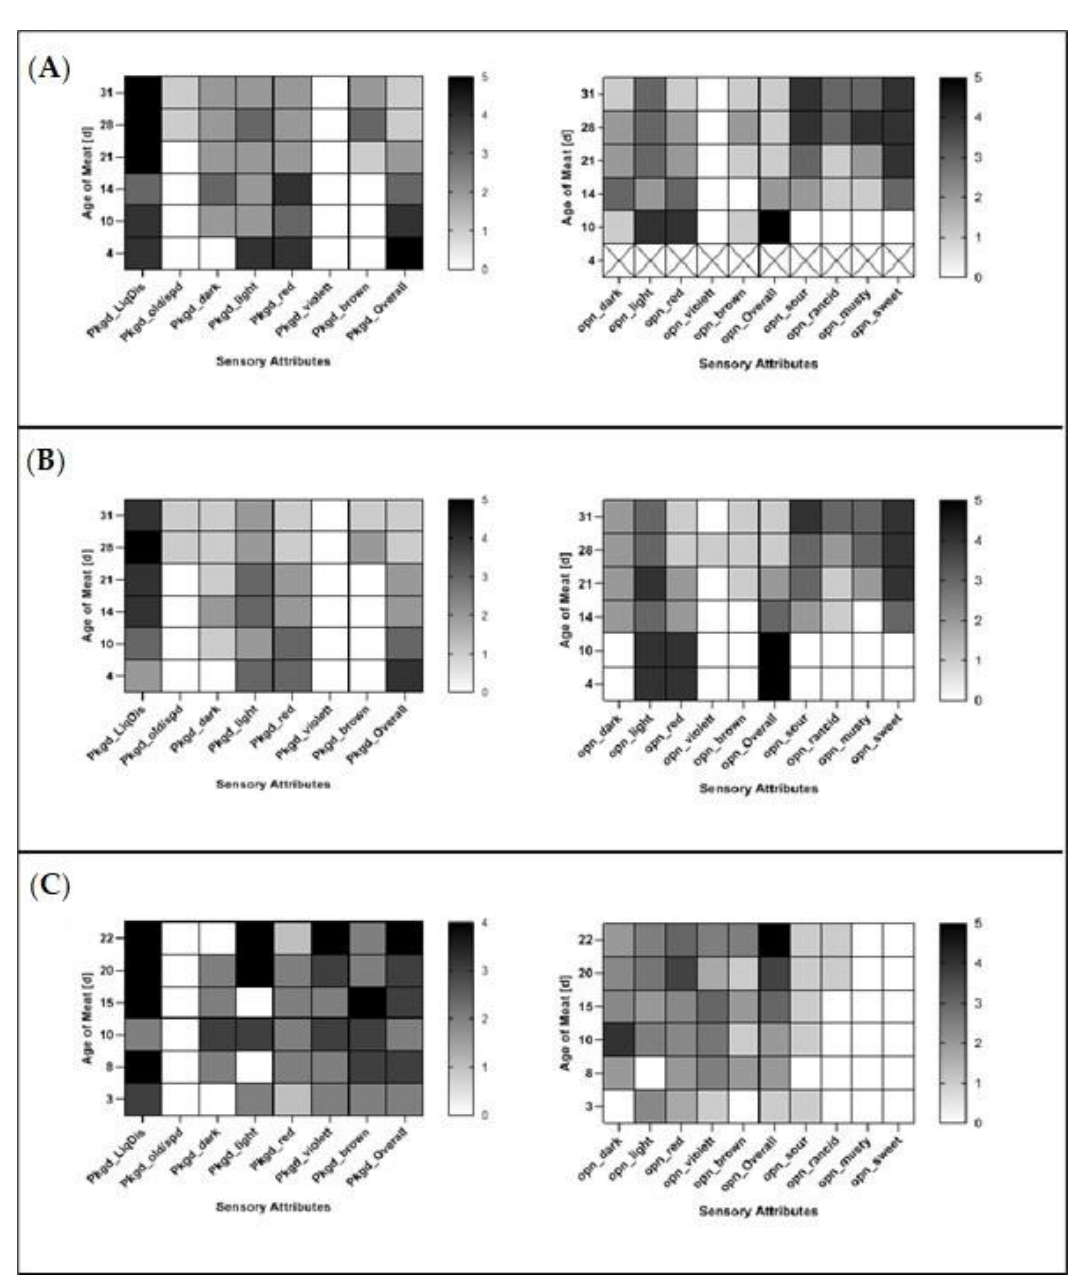
Figure 4. Average sensory evaluation of packaged and opened pork loin (PL) in: ( A ) BioMAP and ( B ) MAP over a meat age of 31 days; and ( C ) VSP over a meat age of 22 days.